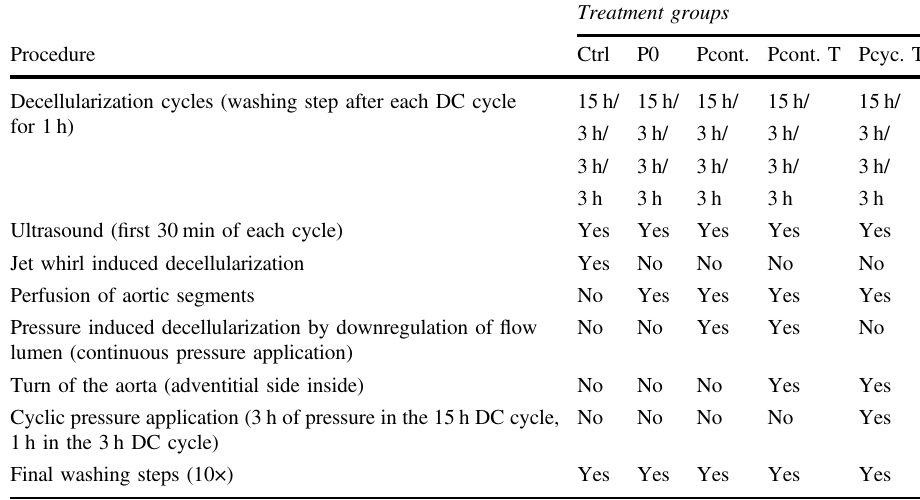
Table 1 Overview of the experimental groups developed for this